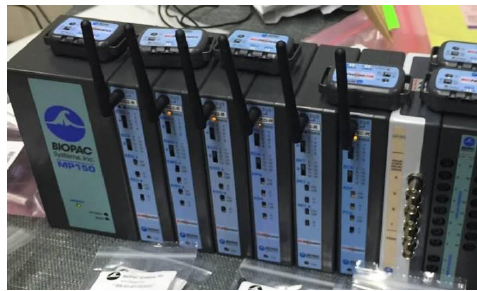
Figure 2. Physiological multi-channel recorder.